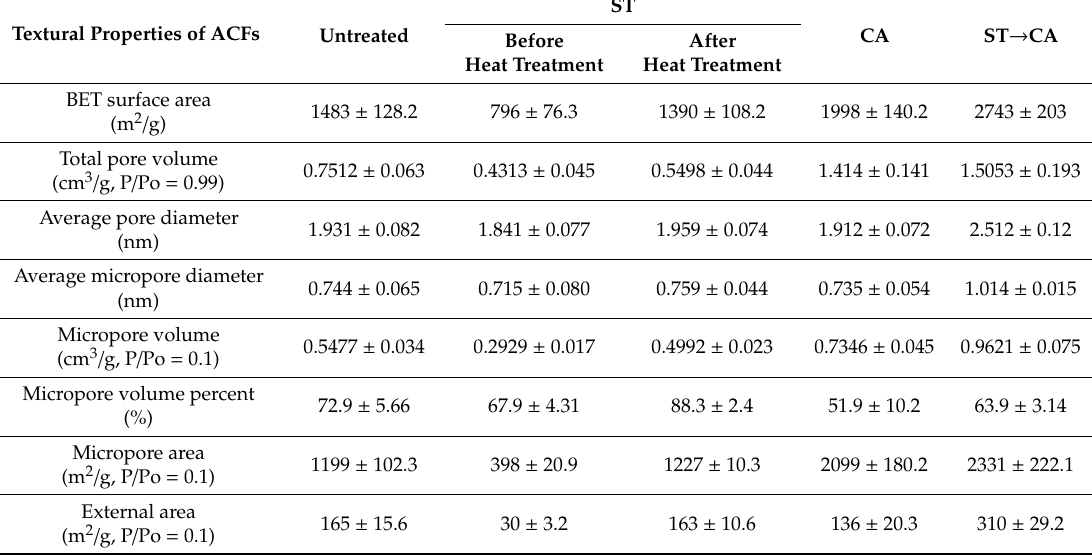
Table 1. Textural properties of ACFs (Untreated, untreated ACFs; ST, ACFs prepared through surface treatment for 80 min; CA, ACFs prepared through chemical activation without prior surface treatment; ST → CA, ACFs prepared through chemical activation after surface treatment for 80 min; n =